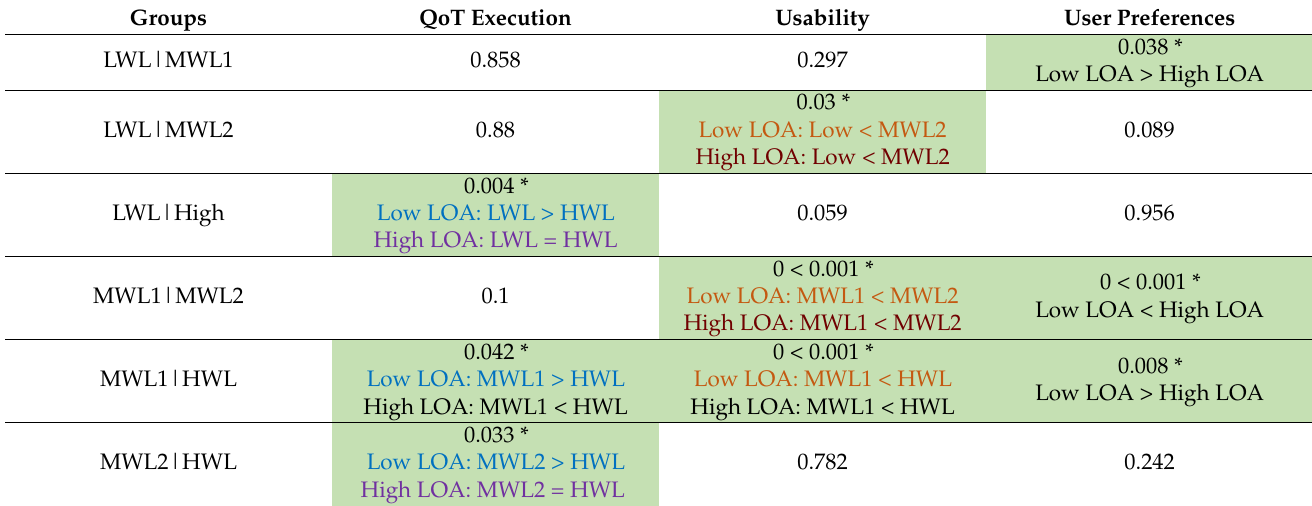
Table 2. Comparison of assessment (with p -values) within the workload groups *.